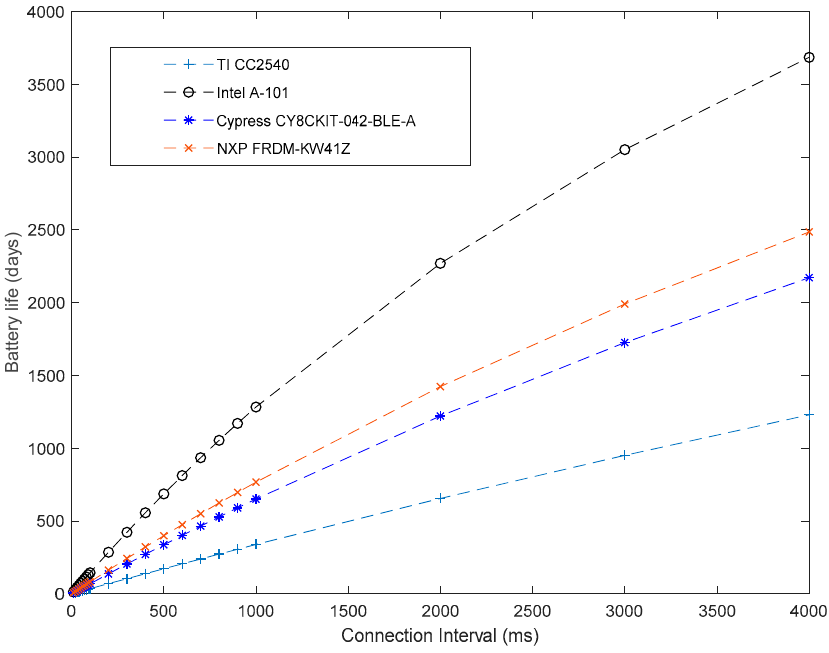
Figure 5. Connection interval vs battery life in PD mode.